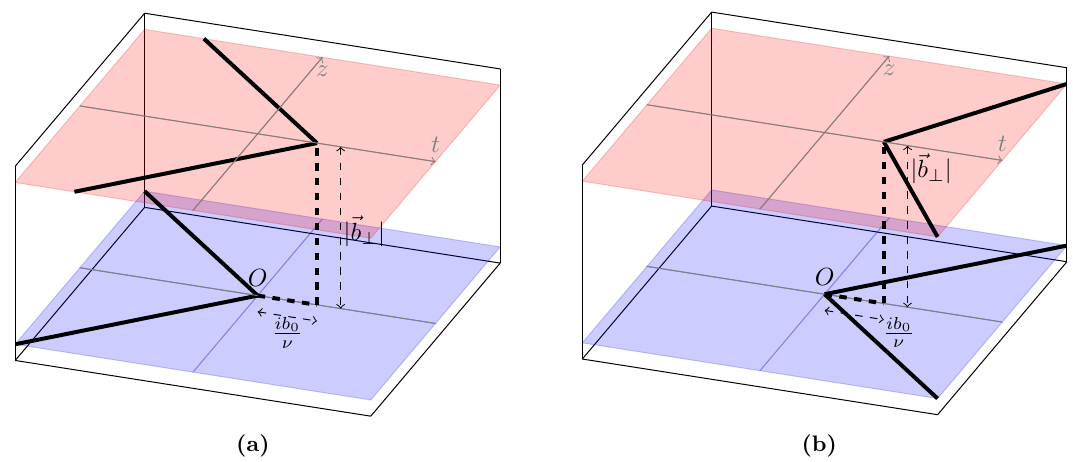
Figure 3. The soft functions for q T for color singlet production in (a) and for the EEC in (b), as de(cid:12)ned in the exponential rapidity regulator of [40]. Solid black lines denotes Wilson lines. Both the rapidity regulator and the measurement are de(cid:12)ned in terms of space-time shifts of the Wilson lines, allowing an all orders proof of the equivalence of these two soft